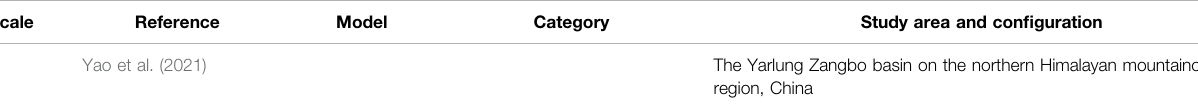
TABLE 3 | ( Continued ) Summary of cold region integrated hydrologic models and their